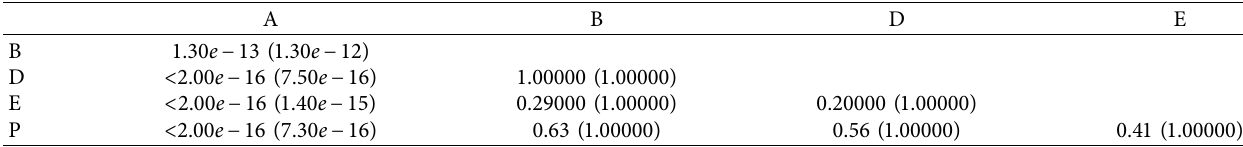
Table 15: In L-Space, for CIT network, pI � 0.05, pR � 0.0025, and T � 65, p -value of the Wilcoxon rank sum test (resultant p -value per Bonferroni correction is indicated in brackets).